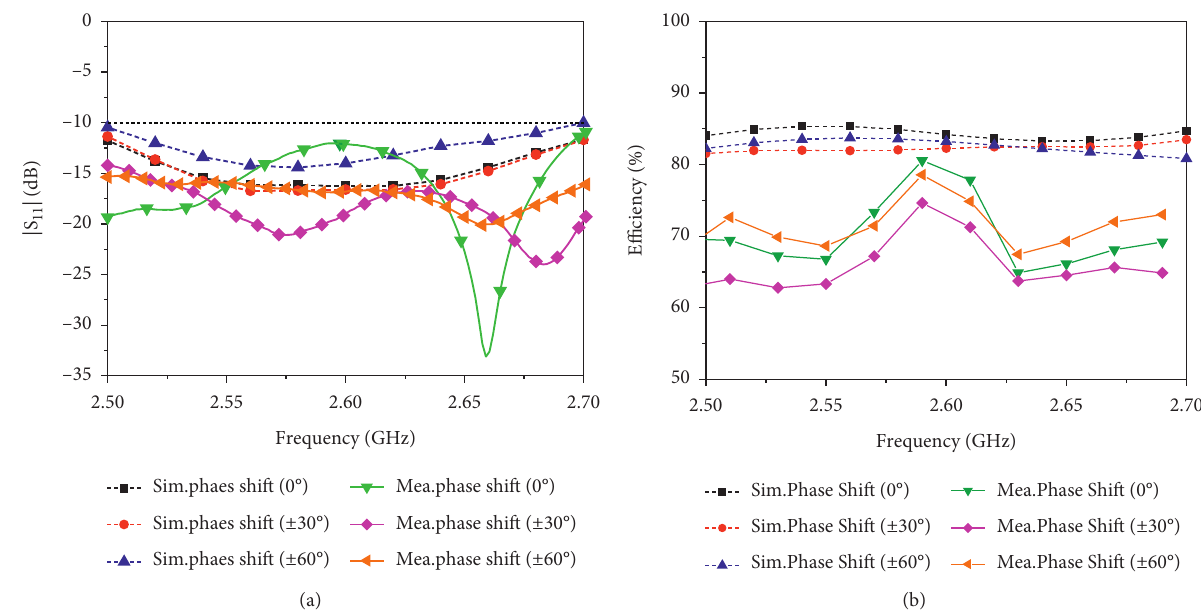
Figure 12: Measured and simulated results of the fabricated antenna array: (a) reflection coefficient |S